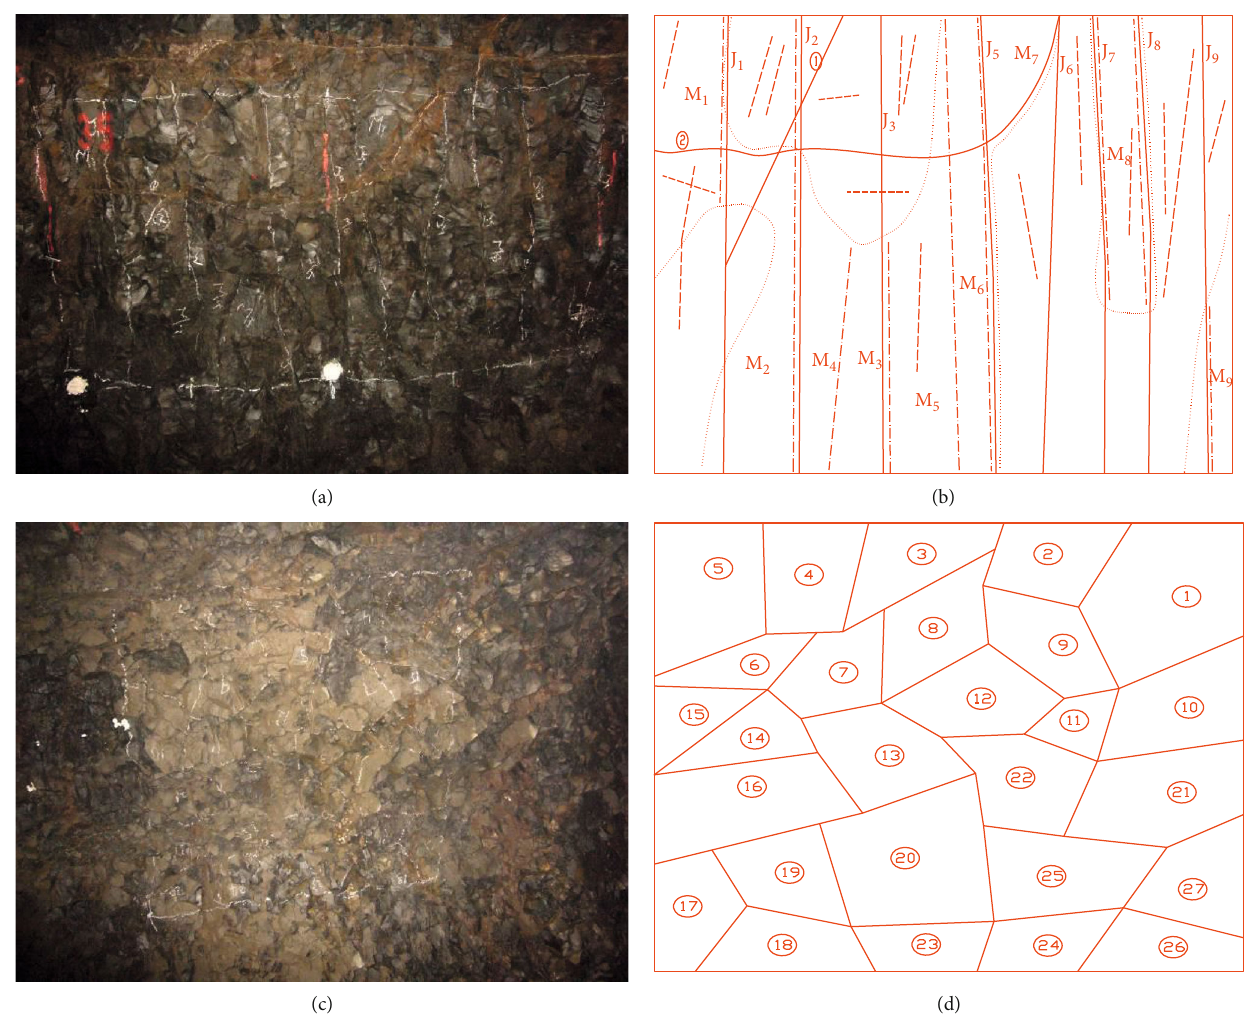
Figure 7: Illustration of microcrack in columnar jointed basalt of PD37: (a) the original photo of adit wall, (b) geologic sketch map of adit wall, (c) the original photo of adit top, and (d) geologic sketch map of adit